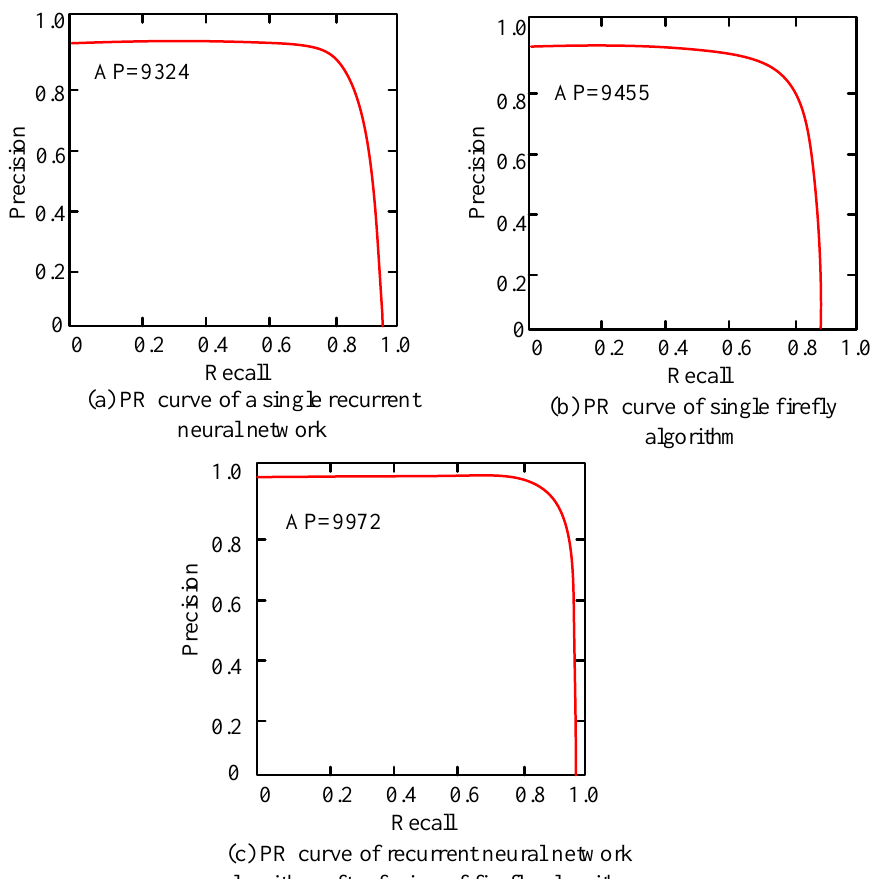
Figure 4. PR curve.